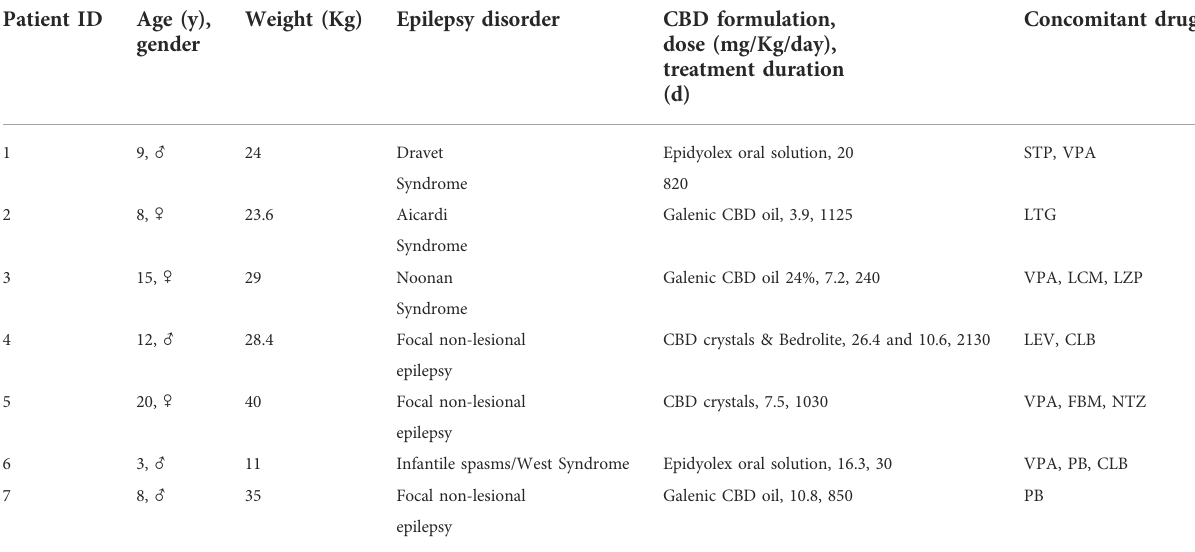
TABLE 2 Patients ’ demographic, clinical, and treatment